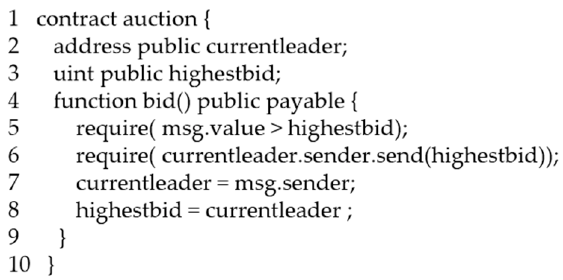
Figure 6. A simplified version of the KotEt contract.